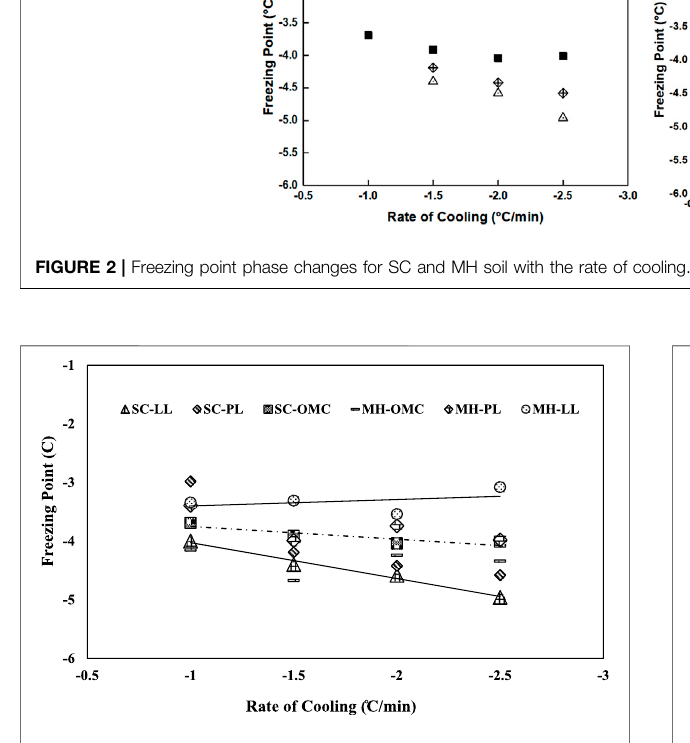
FIGURE 3 | Freezing point with the rate of cooling for elastic silts and clayey sand.